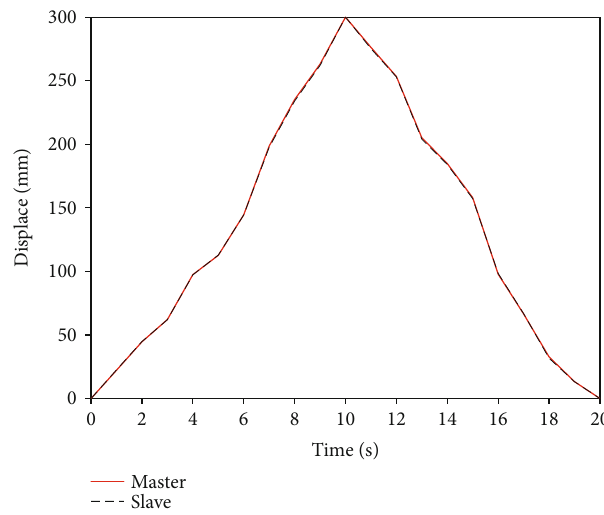
Figure 14: Axial displacement of BP neural network PID controller.